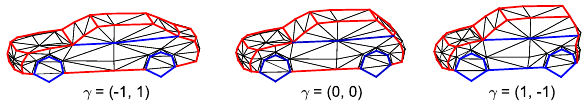
Figure 2. Exemplary ASM with their triangulated surface (black) and wireframe. Red: Crease edges, Blue: semantic edges. Appearance representation: Inspired by Zia et al. (2013), we train a distinct appearance keypoint detector for all keypoints in